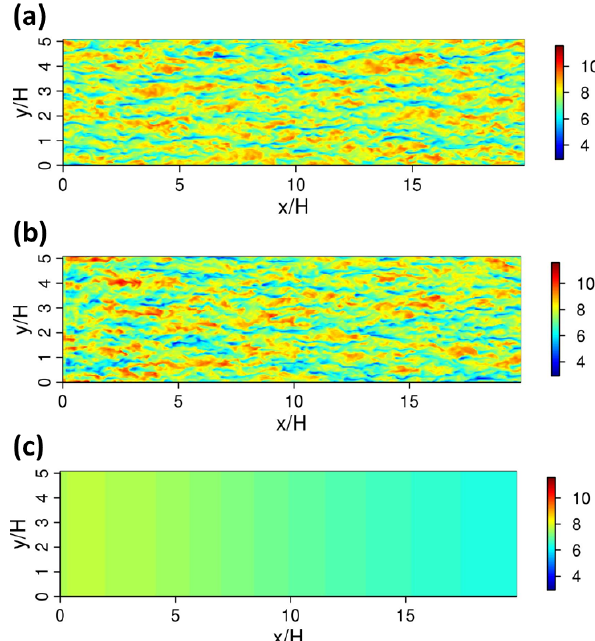
Figure 2. Horizontal slice of instantaneous streamwise velocity component, u (ms − 1 ), at z/H = 0 . 1 after a simulation time of 6h: (a) the fully periodic case, (b) the synthetic inflow BASE case (LS1.0), and (c) the inflow case without perturbations at the